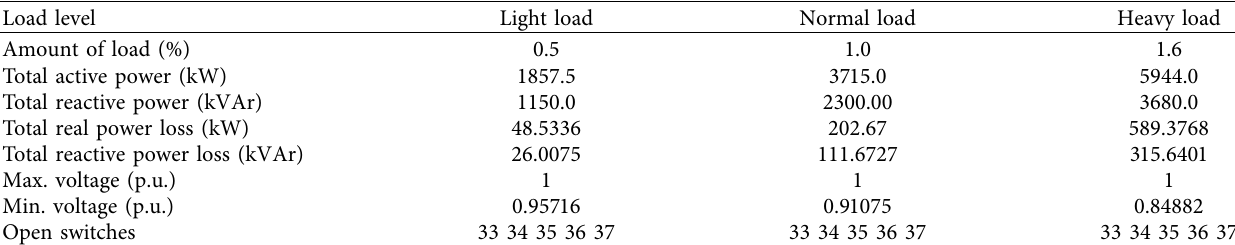
Table 4: Details of the 33-bus system loading states before